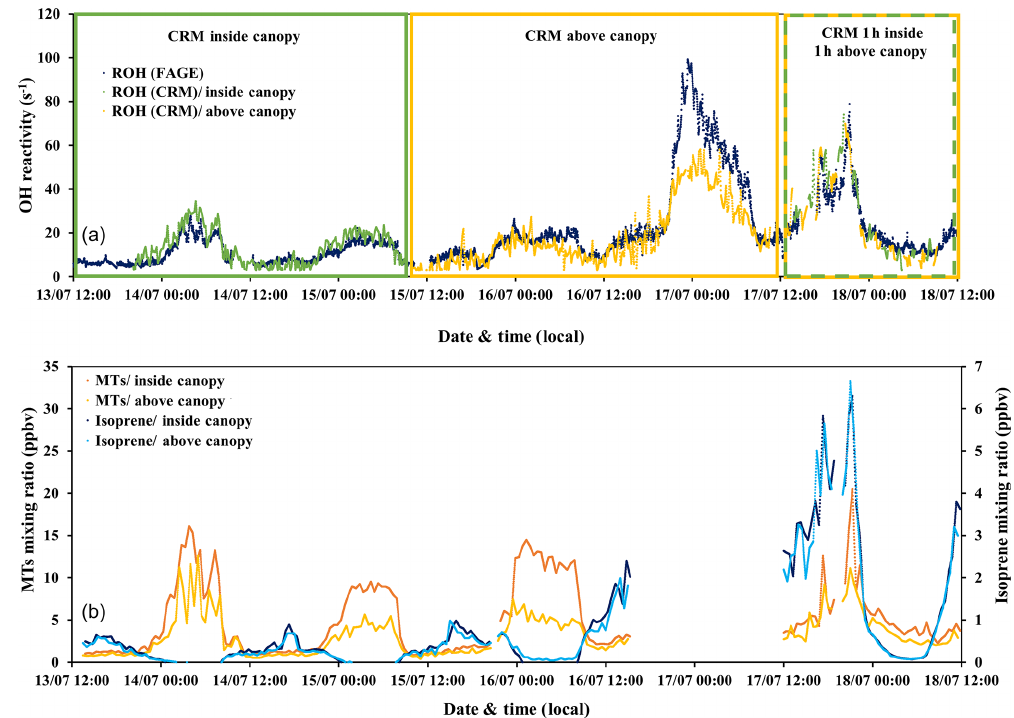
Figure 4. (a) Time series of total OH reactivity measured by the UL-FAGE and LSCE-CRM instruments from 13 to 18 July 2017 (a) . Dark blue symbols represent the measured reactivity by UL-FAGE; green and yellow symbols represent the measured reactivity by LSCE-CRM inside and above the canopy, respectively. (b) The sum of monoterpenes (MTs) and isoprene measured with the PTR-MS in the field for the same period. Dark blue and light blue dots correspond to isoprene concentrations at 6 and 12m of height, respectively. Orange and yellow dots represent monoterpene concentrations at 6 and 12m of height,